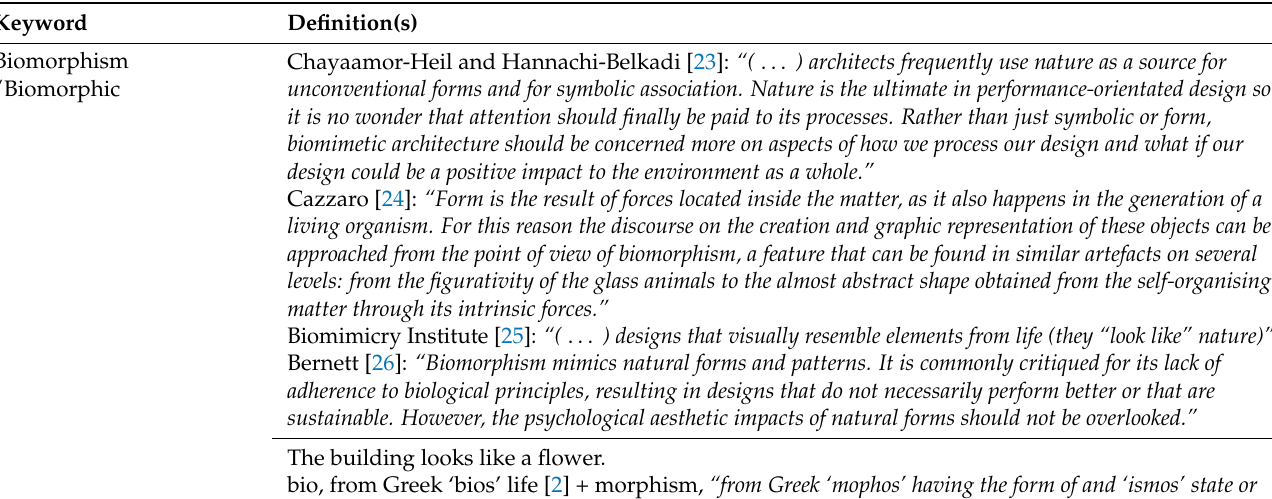
Table 1. Definitions of biomimicry-related keywords in the format of quotes of several authors, all employing nature as a generator for design in the broadest sense of this